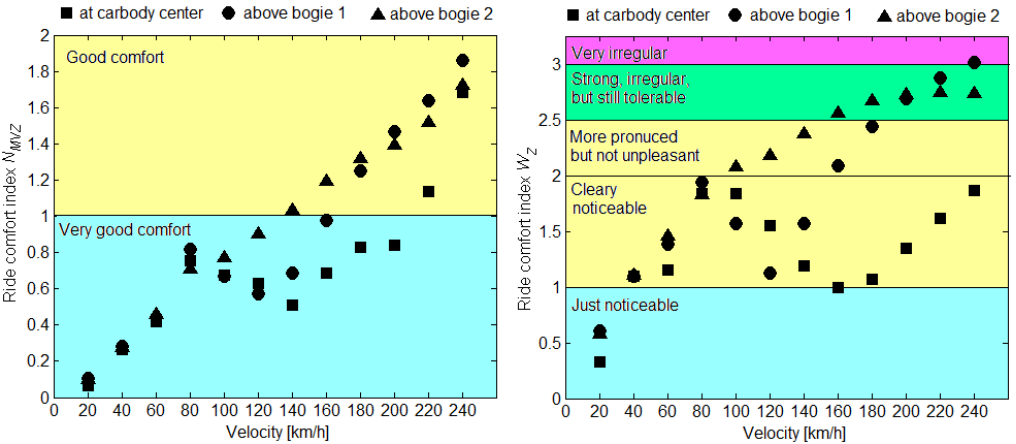
Figure 12. Ride comfort indices depending on the vehicle velocity.